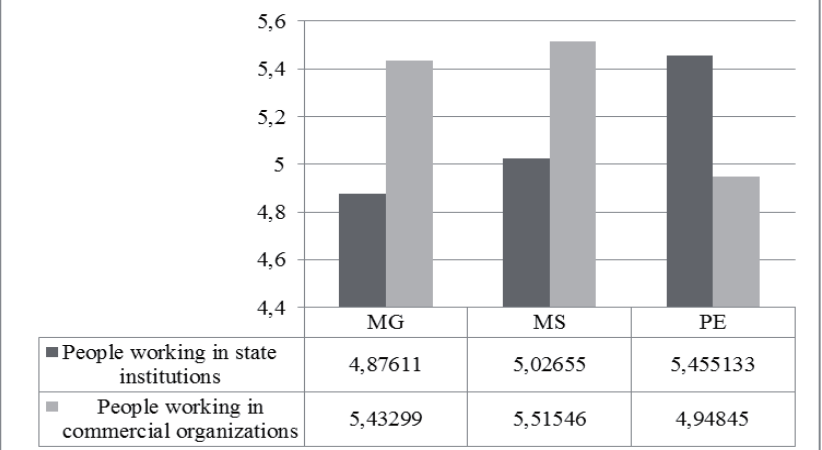
Figure 5. Statistically signi  cant differences in indicators of money attitudes in people with different employment